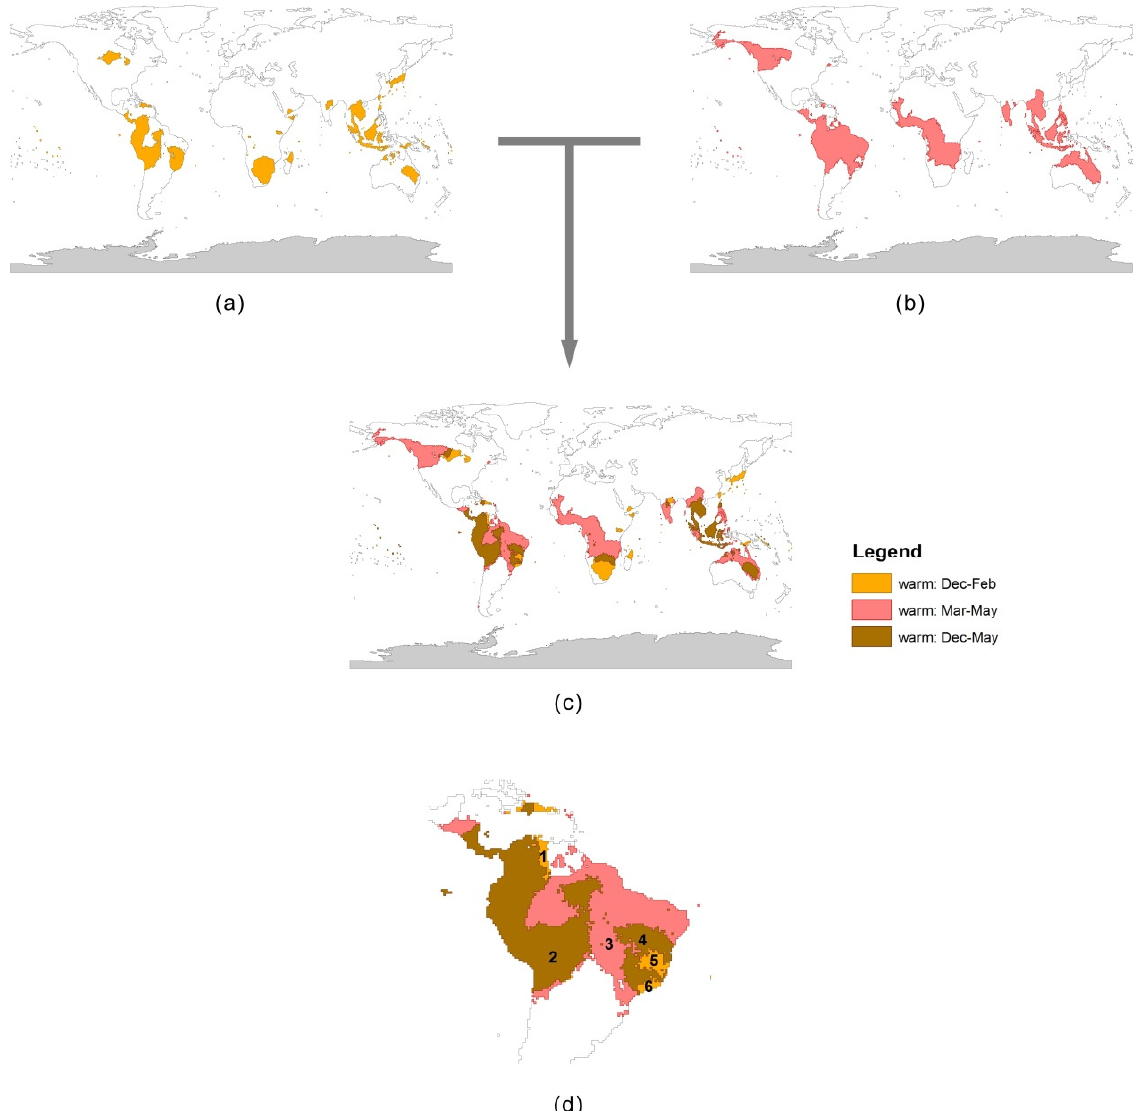
Figure 2. An example of overlapping flocks. ( a ) The warm flock in boreal winter: Flock T-w: Dec-Feb. ( b ) The warm flock in boreal spring: Flock T-w: Mar-May. ( c ) The overlap of the two flocks above. ( d ) A zoom of South America.